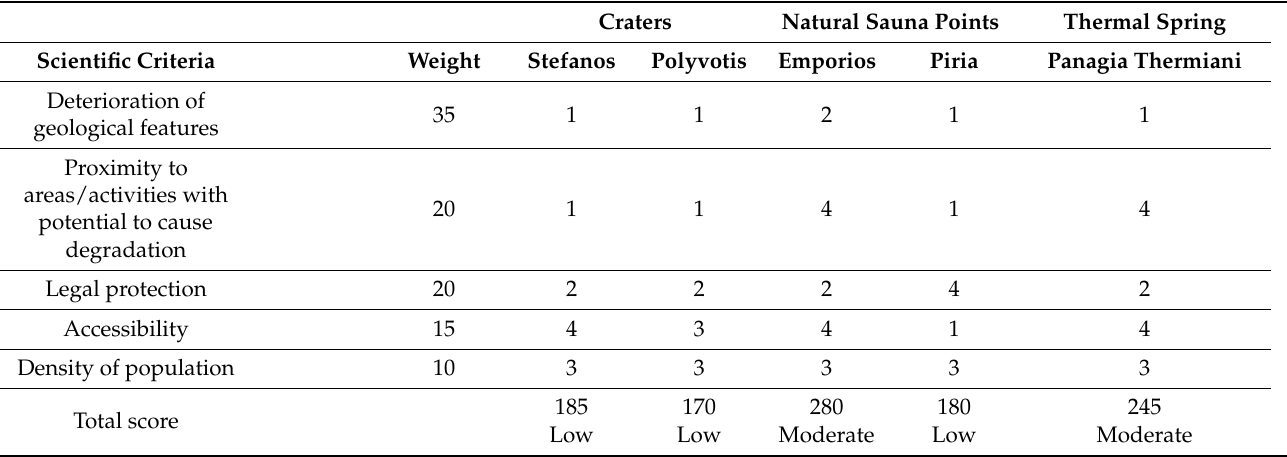
Table 5. Degradation risk evaluation of geosites.